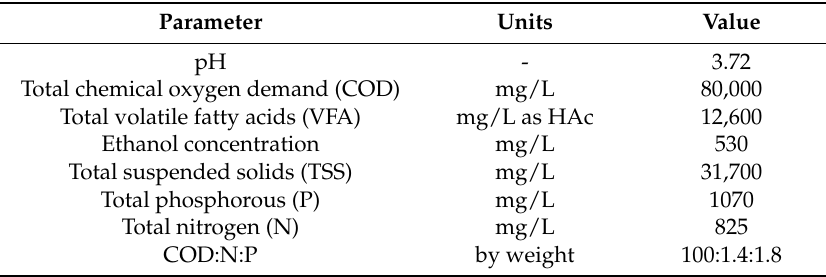
Table 1. Characteristics of the ethanol wastewater used in this